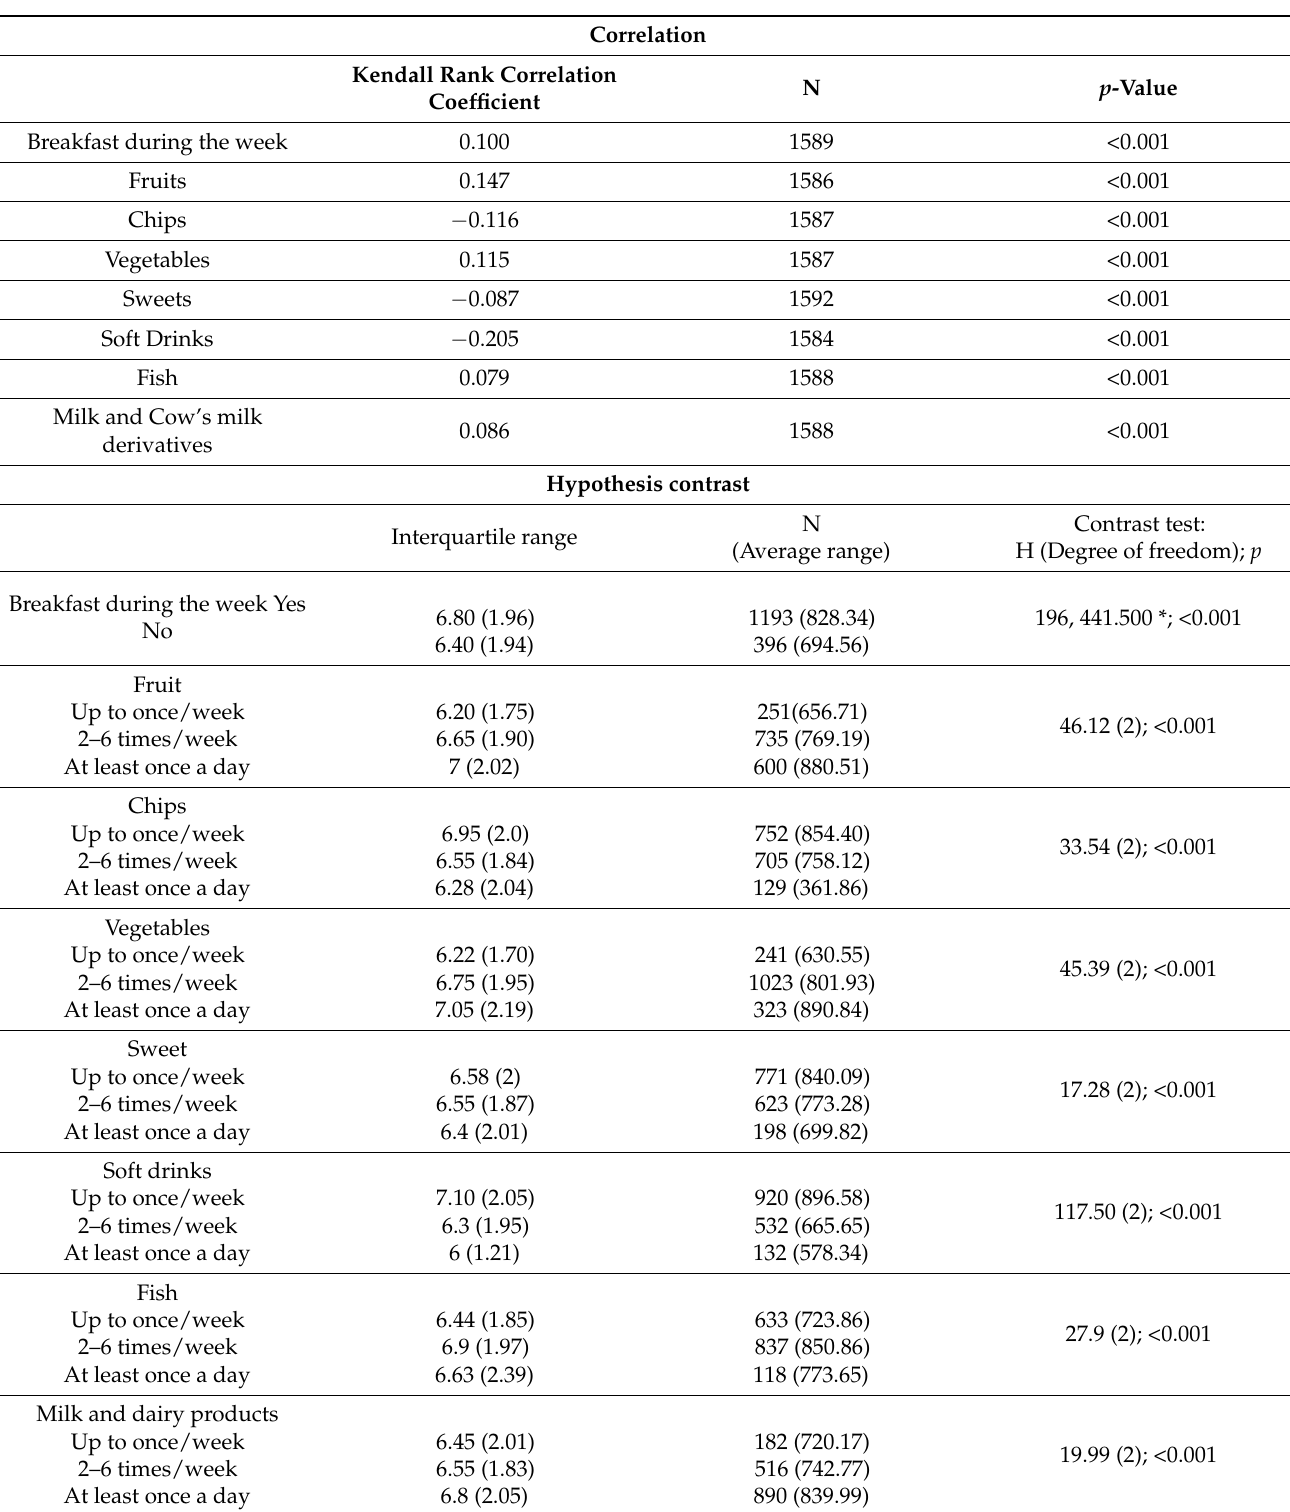
Table 1. Relationship between dietary habits and academic performance.